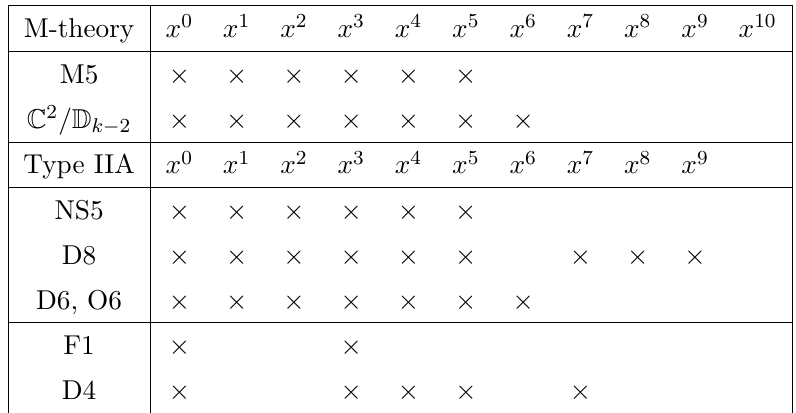
Table 1 . Upper part: occupation of space-time directions by M5, and D k singularity in M-theory. Lower part: occupation of space-time directions by NS5, D8, D6, and O6 in Type IIA. The fundamental string F1 and the D4 branes are virtual objects which are used to read o(cid:11) the electric and magnetic